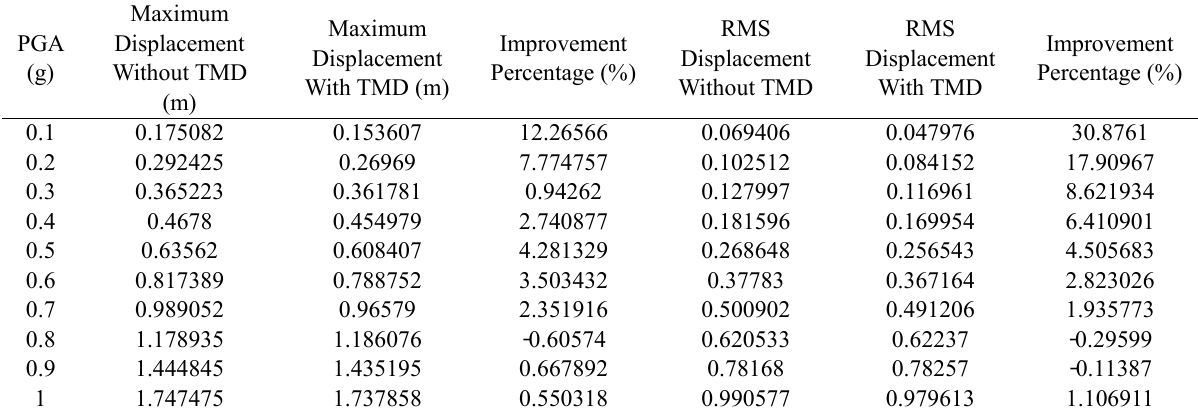
Average Value of the Max Displacement and RMS of the Roof of an Irregular Mass Structure, on the first floor, based on Near-Field Earthquakes .